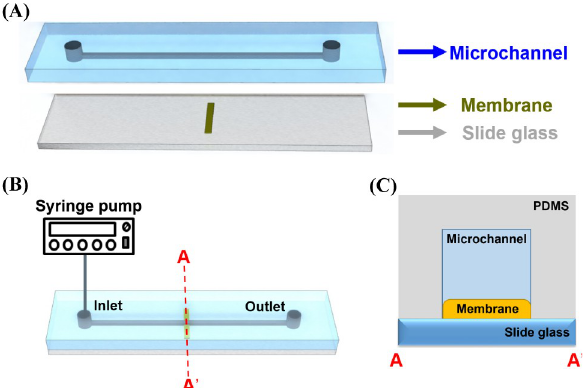
Fig 2. A schematic of the experimental setup. (A) Two microchannels with a width of 500 μ m in width and depths of 55 and 10 μ m were fabricated. Three membranes with different SZP values were inserted between a slide glass and the PDMS channel. (B) The PDMS channel and the slide glass were bonded using O 2 plasma etching. The feed solution containing an ionic solution and fluorescent dyes were supplied to the inlet, and behaviors of fluorescent dyes were observed using an inverted microscope. (C) A cross-sectional view of the experimental setup.